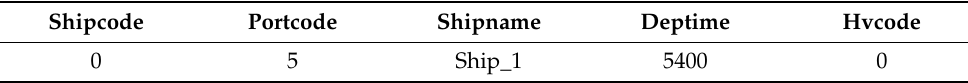
Table 2. Snapshot of processed traffic